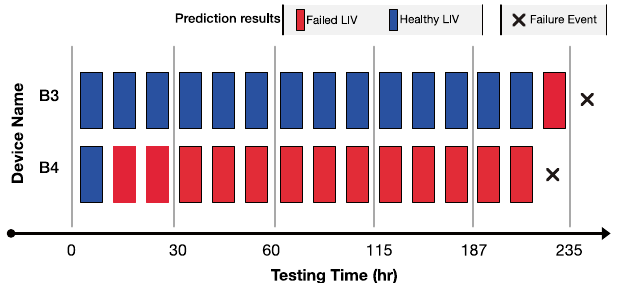
Figure 5. SVM testing results for the second stage of experiments. Rectangles represent measurement events at different time points, while their color represent the model’s prediction. The failure event is marked with a black